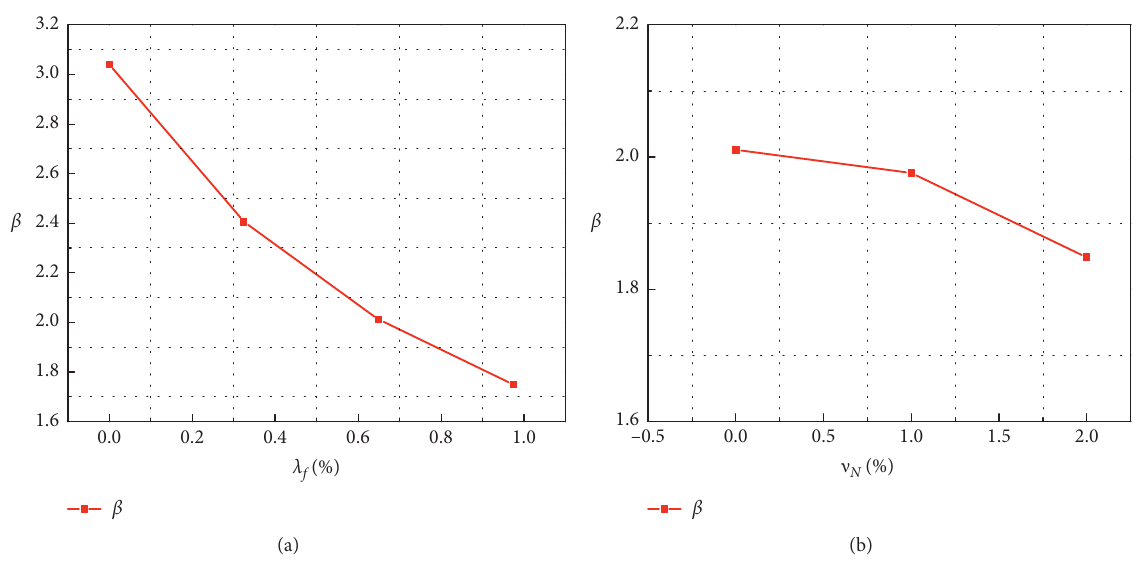
Figure 14: Relationship of β with (a) λ